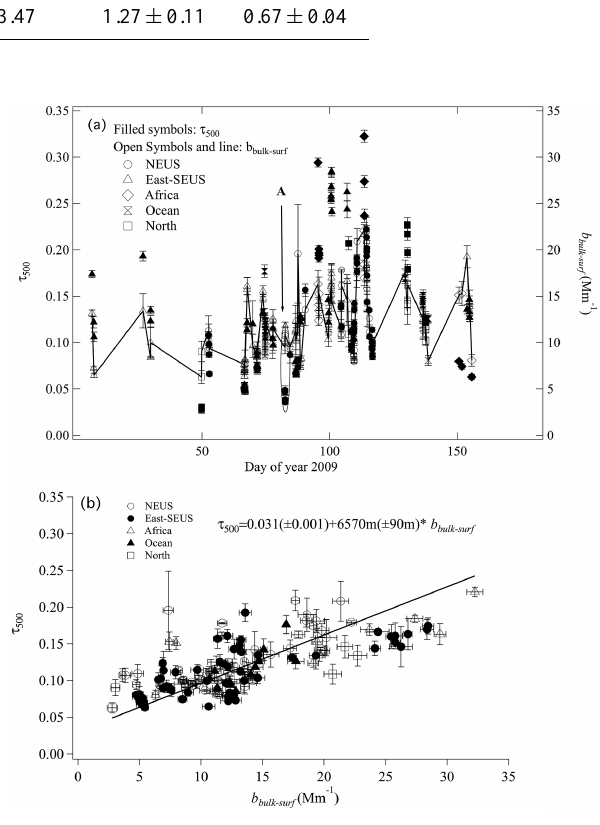
Figure 2. (a) Time series column τ 500 derived from Cimel Sunpho- tometer (AERONET products) and (b) the corresponding b bulk-surf scatterplot of these two parameters. The line in (b) is as described in 2.3.6; r 2 = 0 . 49. Error bars depict standard